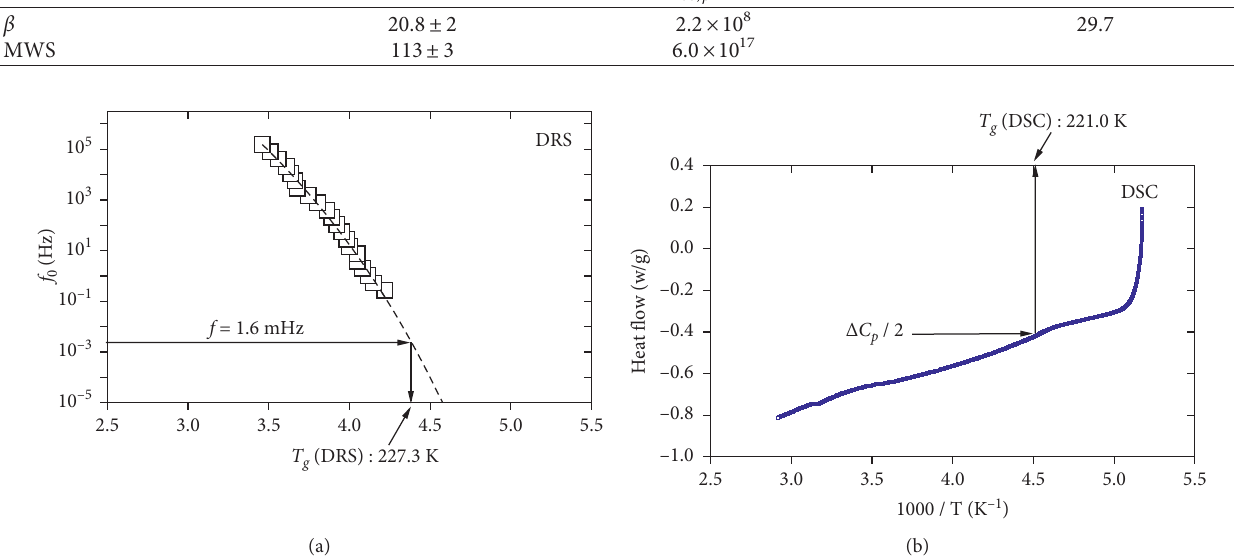
Table 7: The activation energy and pre-exponential factor for MWS and β -relaxations in EPDM. Type of relaxations